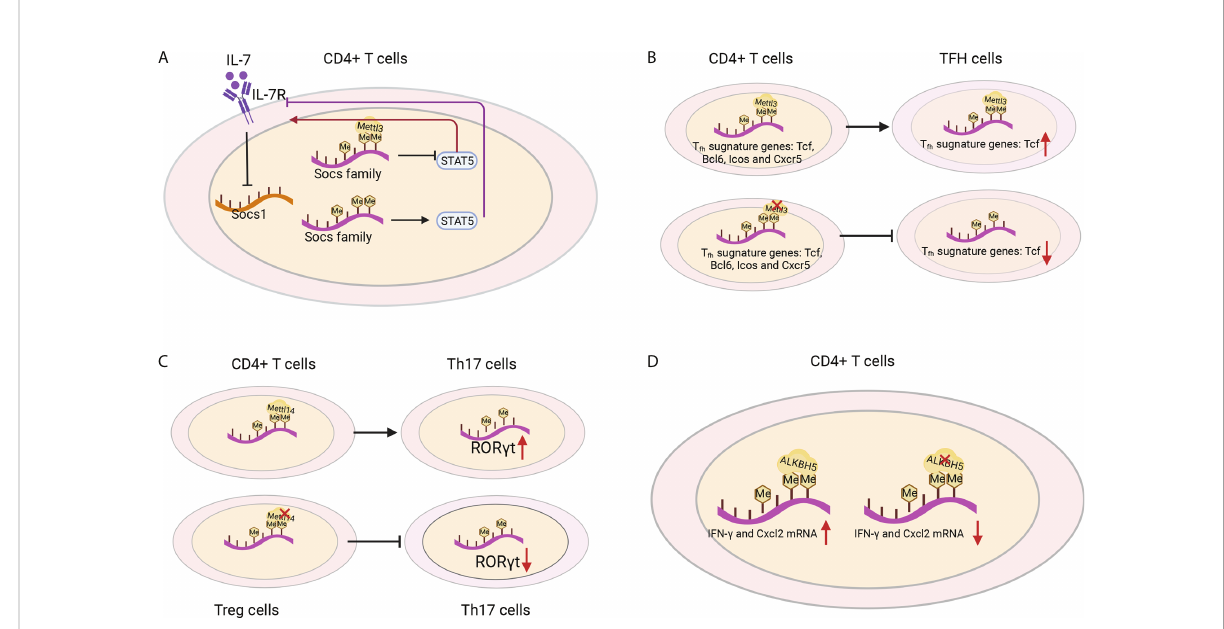
FIGURE 6 T-cell functions were shaped by m6A regulators. (A) IL-1R is a suppressor of SOCS1 targets. The Socs family prevents STAT5 activation and downstream signaling, which are marked by m6A and show slower mRNA degradation and higher protein expression in Mettl3 -de fi cient T helper cells and blocked signal transduction through IL-7R. (B) Loss of METTL3 in CD4+ T cells leads to the degradation of the T fh signature gene Tcf7 and inhibits T fh cell differentiation. (C) Mettl14 ablation in Treg cells decreases ROR g t expression and blocks the differentiation of naïve T cells into Th17 cells. (D) ALKBH5 de fi ciency in CD4+ T cells increases the m6A modi fi cation of IFN- g and CXCL2 mRNA, thus decreasing their mRNA stability and protein expression in CD4+ T